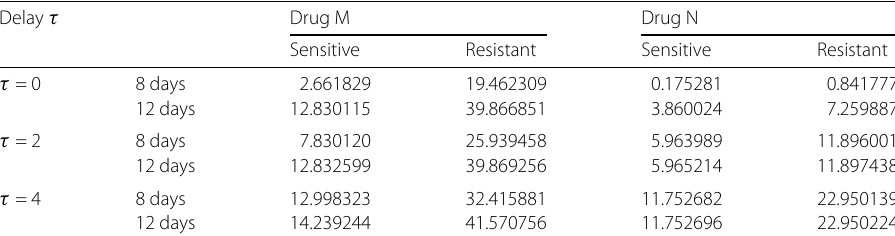
Table 2 Areas under the prevalence curves according to the time period of 8 and 12 days